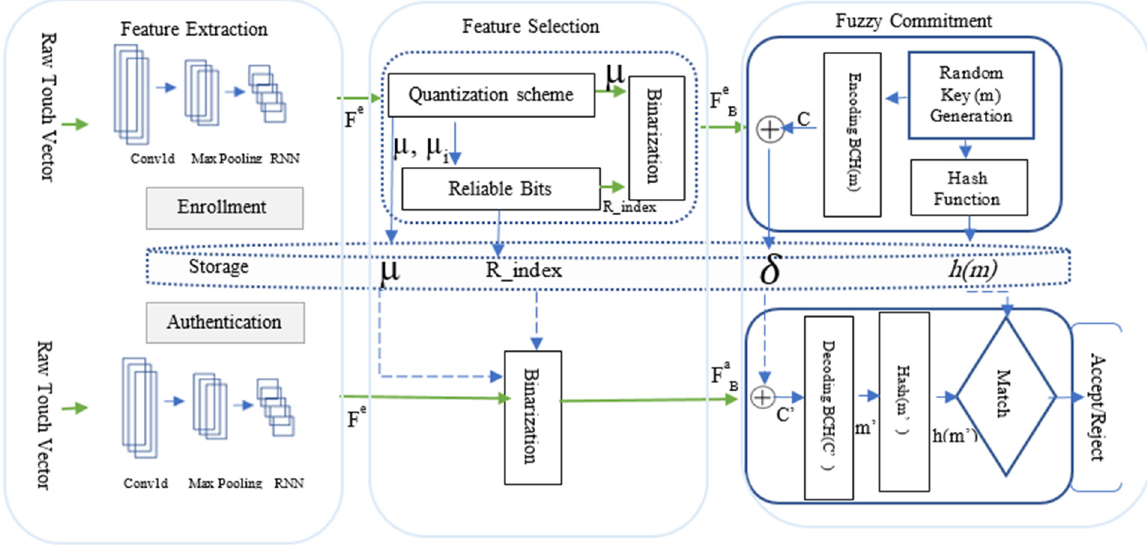
Figure 1. The proposed template protection for touch gestures. Where µ : inter-class mean, µ i : intra- class mean, δ : secured template, C: codeword features, F e : enrollment feature, F a : authentication feature, R_index: the indices of most reliable features, h(m) : hash of the message m , F eB : binary en- rollment feature , F aB : binary authentication.